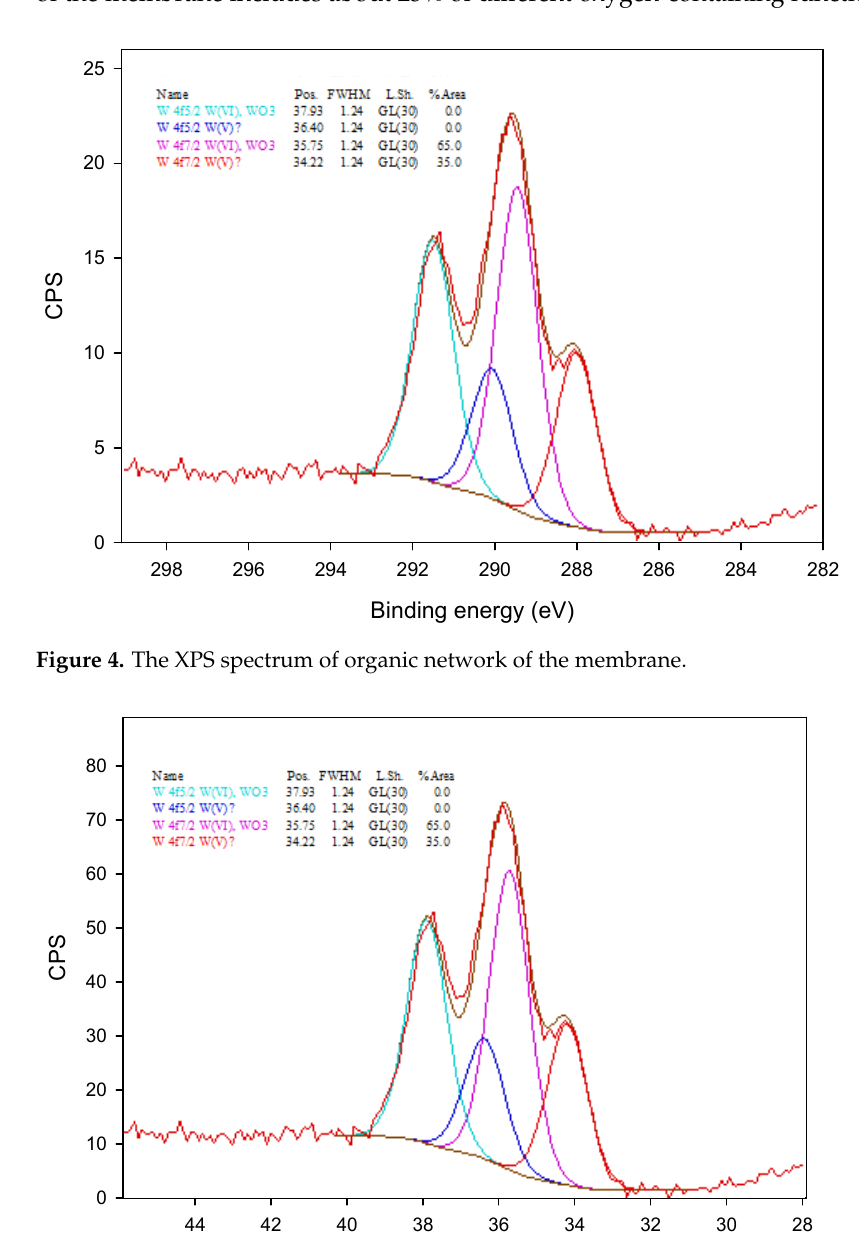
7 of 13 correspond to the C-C carbon chain with C-H bonds (284.8 eV) and to the different oxy- genated functionality of the C-C skeleton (C-OH bonds at 286.3, C=O bonds at 287.8 and CO(OH) groups at 289.1 eV). It can also be seen from Figure 4 that the organic matrix of the membrane includes about 23% of different oxygen-containing functional groups. In Figure 5, the W